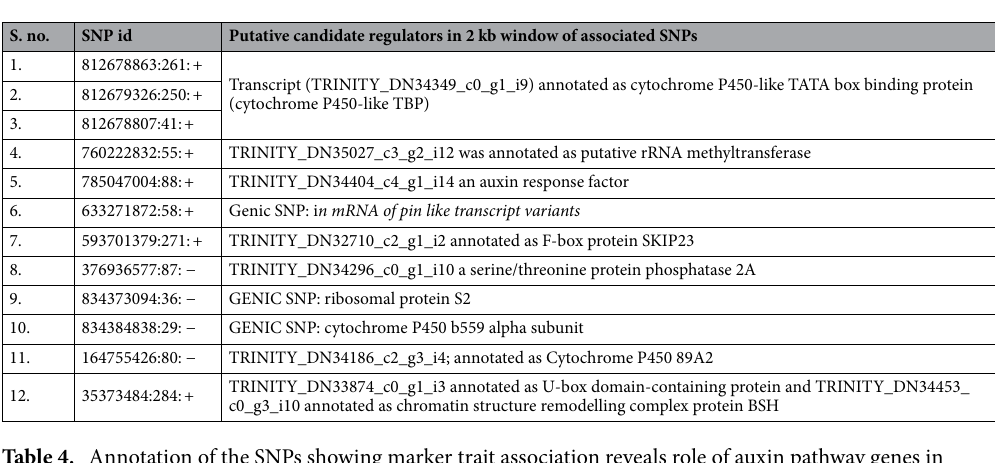
Table 4. Annotation of the SNPs showing marker trait association reveals role of auxin pathway genes in flower induction.